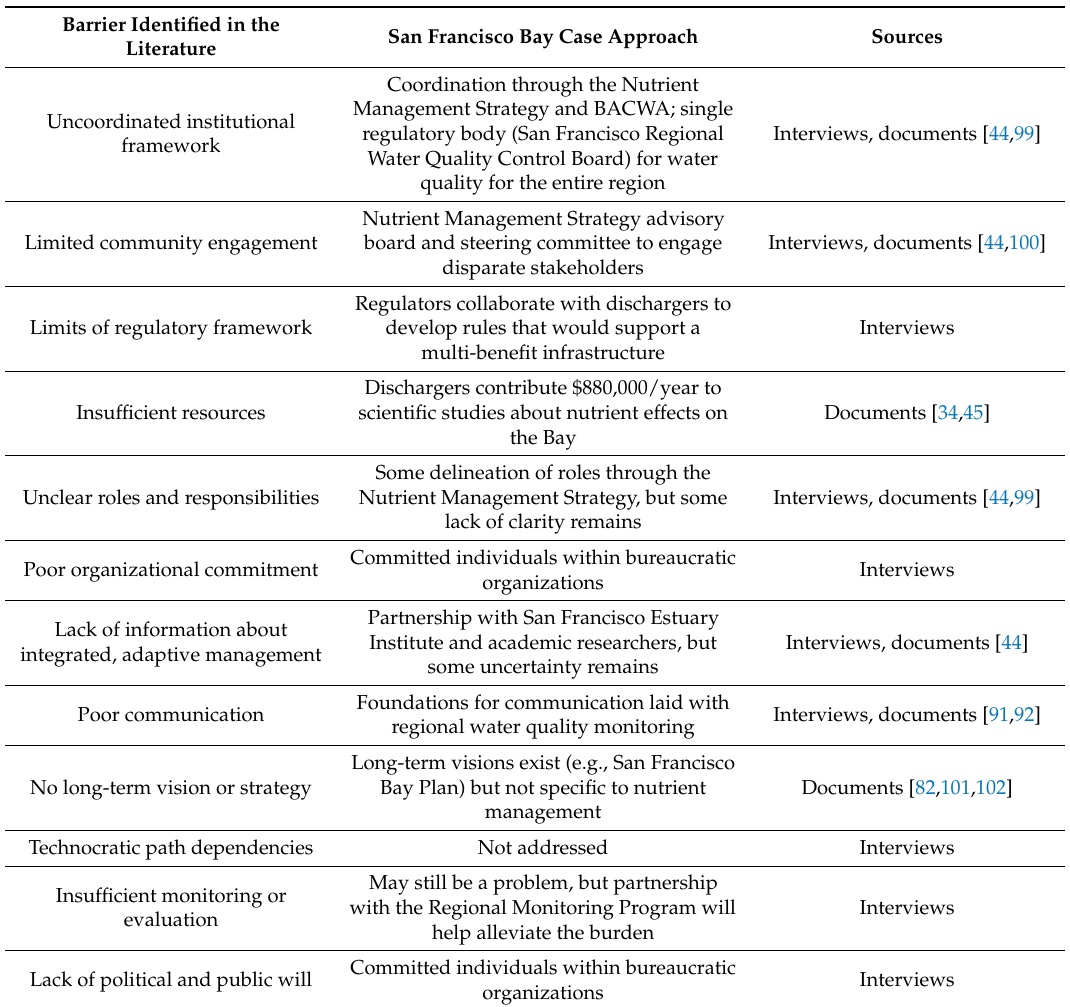
Table 5. Barriers to sustainable water infrastructure management adapted from a review by Brown and Farrelly (2009) [25] and the San Francisco Bay approach, which is identified in stakeholder interviews and document